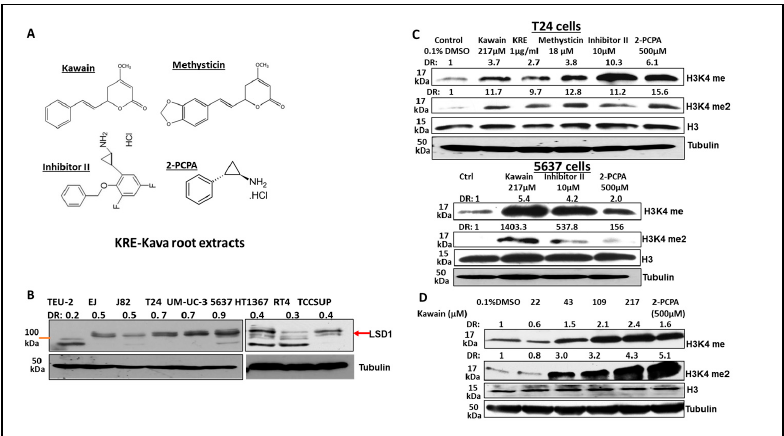
Figure 5. Kava root extracts, kawain, and methysticin induce mono- and di-methylation of H3K4 in bladder cancer cell lines. ( A ) Chemical structures of kawain, methysticin, 2-PCPA, and inhibitor II. Bladder cancer cells were treated for 24 h with the indicated concentrations of kawain, kava root extracts (KRE), and methysticin. ( B ) Western blotting analysis of LSD1 expression in non-malignant bladder epithelial TEU-2 cells and bladder cancer cell lines. ( C ) Western blotting analysis was performed to examine the methylation status of H3K4 in T24 cells and 5637 cells using specific anti-H3K4me and me2 antibodies (Abcam). Histone H3 and tubulin were used as internal controls. A representative blot from three independent experiments was shown. ( D ) T24 cells were treated with different concentrations of kawain and 500 µM 2-PCPA for 24 h. Expression of H3K4me and H3K4me2 was examined similarly, as described above.